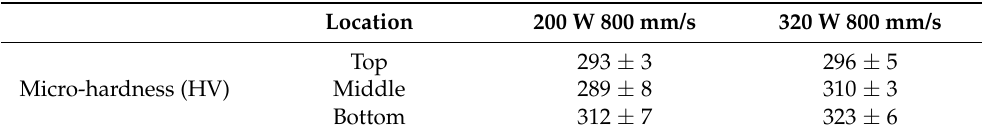
Table 3. Micro-hardness of the SLMed CLF-1 steel.